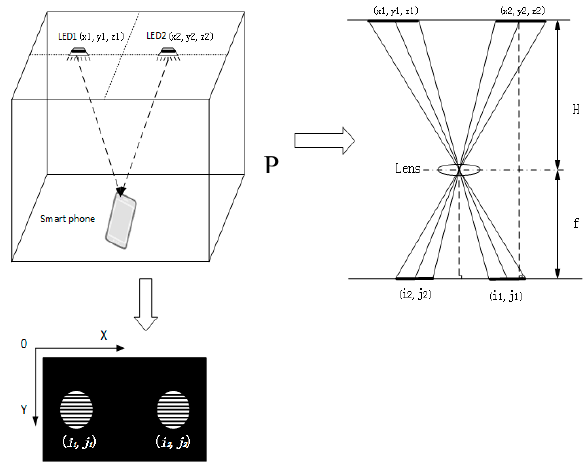
Figure 3. Double-light positioning system model.